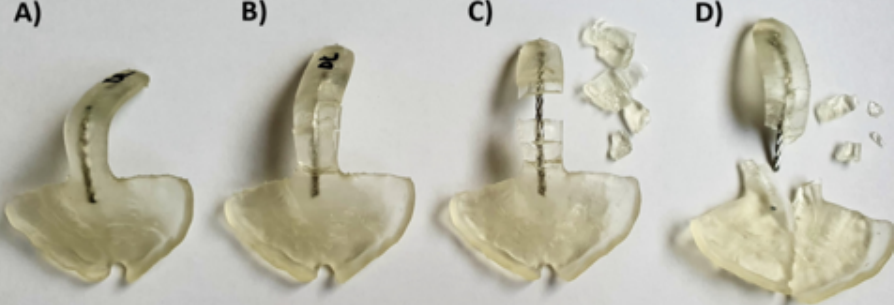
Figure 10. Different breaking patterns were observed in TPPs with wire from the ideal case (left) to the worst scenario (right) in Dental LT clear SLA material. ( A ) Ideal case, no cracks after application of the force; ( B ) sample broke, all pieces attached to the wire; ( C ) sample broke, the biggest parts still attached to the wire, smaller ones detached from the wire; ( D ) worst scenario, where the sample broke and the safety wire, as well as all pieces, are completely detached from the palatal plate and go further in the pharynx of the patient.